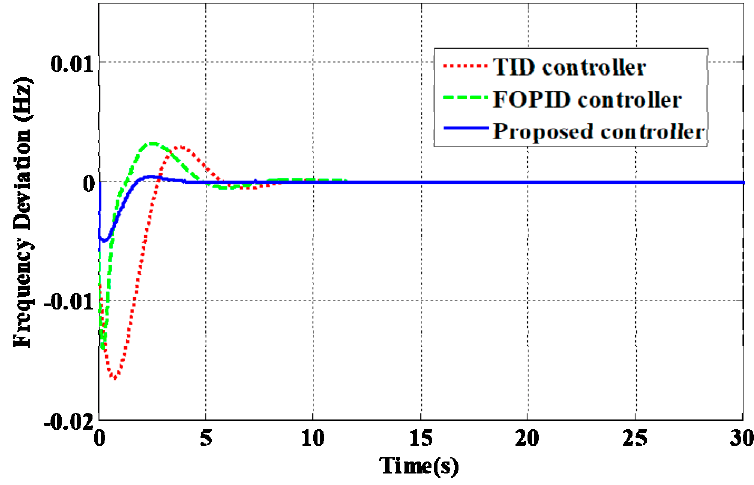
Figure 9. Resulted frequency responses for scenario 5.1.1. Table 2. Dynamic characteristic of considered controllers for scenario 5.1.1.